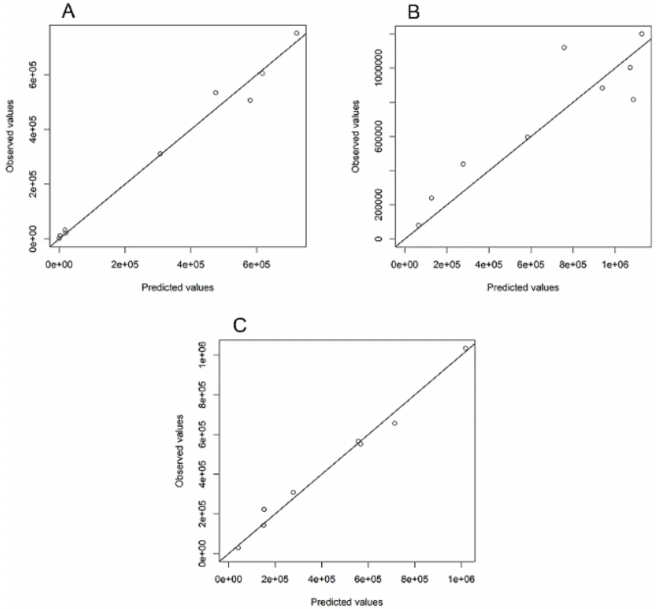
Figure 4. Visual assessment of prediction of epidemic sizes from 2010 to 2019. ( A ) Correlation between the predicted and observed epidemic sizes of influenza A / H1N1. The chosen thresholds were h = 250,000 and h c = 570,000. ( B ) Correlation between the predicted and observed epidemic sizes for influenza. The statistically chosen thresholds were h = 480,000 and h c = 700,000 cases. ( C ) Correlation between the predicted and observed epidemic sizes for influenza B. The statistically chosen thresholds were h = 310,000 and h c = 810,000 cases, respectively.